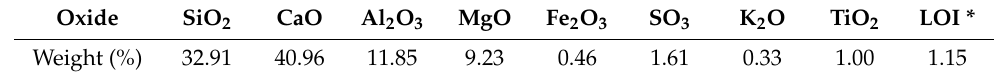
Table 1. Chemical composition of GGBFS.